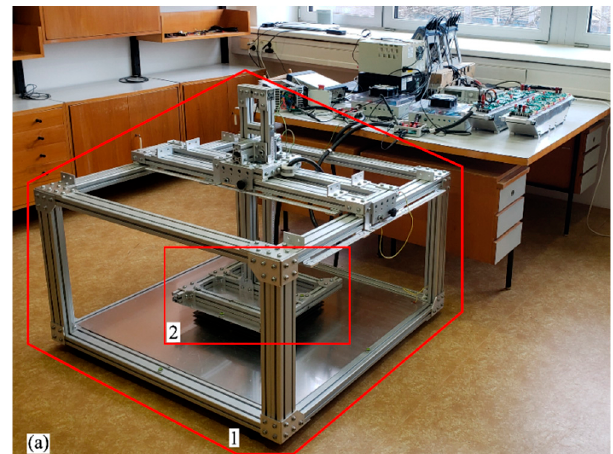
Table 1. System parameters in the position x = 0